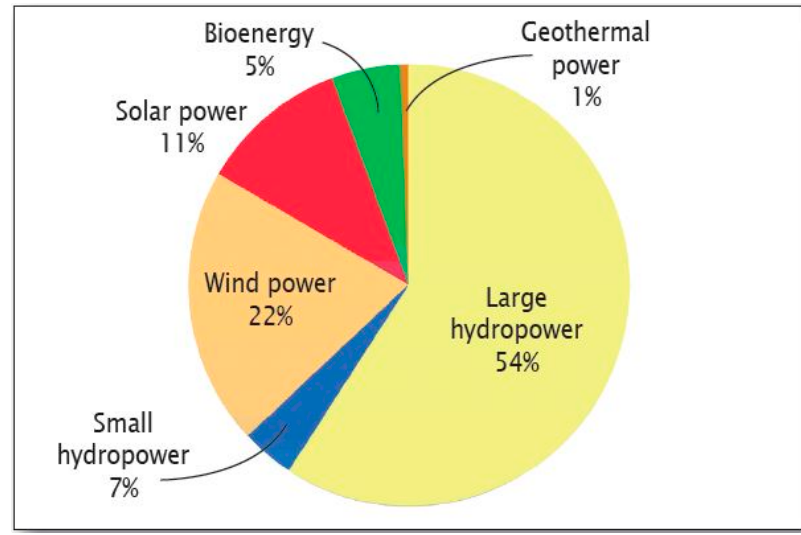
Figure 1. World energy consumption history and projection by energy sources [1].